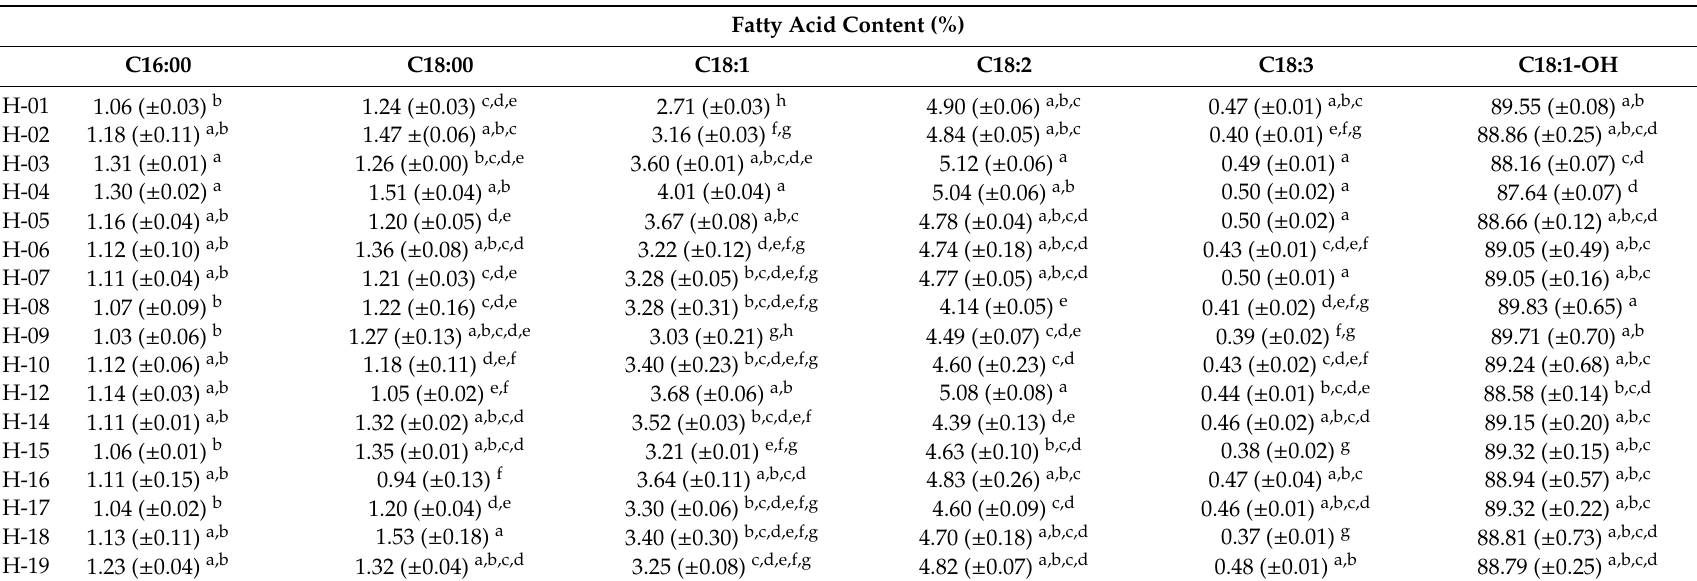
Table 2. Fatty acids profile of seventeen castor bean Chilean